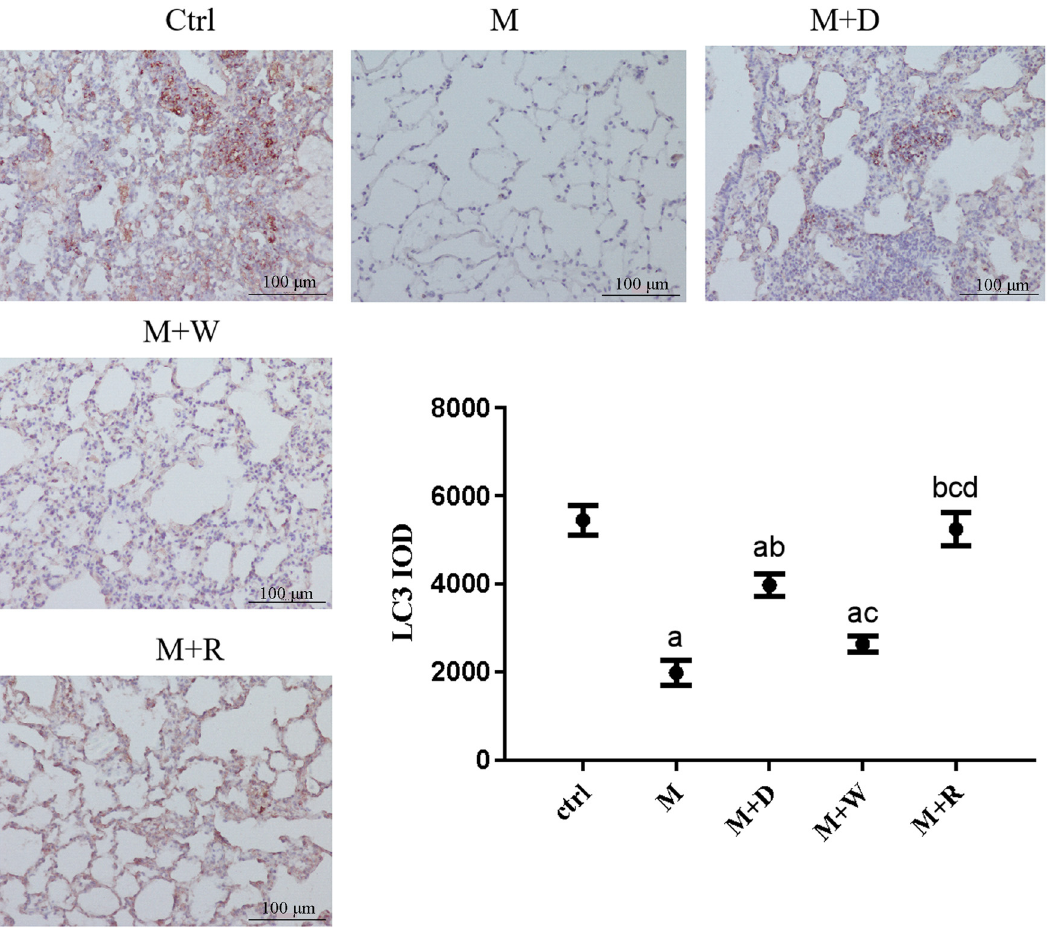
Figure 6: IHC image and expression levels of the mitochondrial autophagy marker Beclin1 in the lung tissues of rats in each group (× 200 ) : ( a ) statistically signi fi cant di ff erence from the Ctrl group ( P < 0.05 ) , ( b ) statistically signi fi cant di ff erence from the M group ( P < 0.05 ) , ( c ) statistically signi fi cant di ff erence from the M + D group ( P < 0.05 ) , and ( d ) statistically signi fi cant di ff erence from the M + W group ( P < 0.05 )